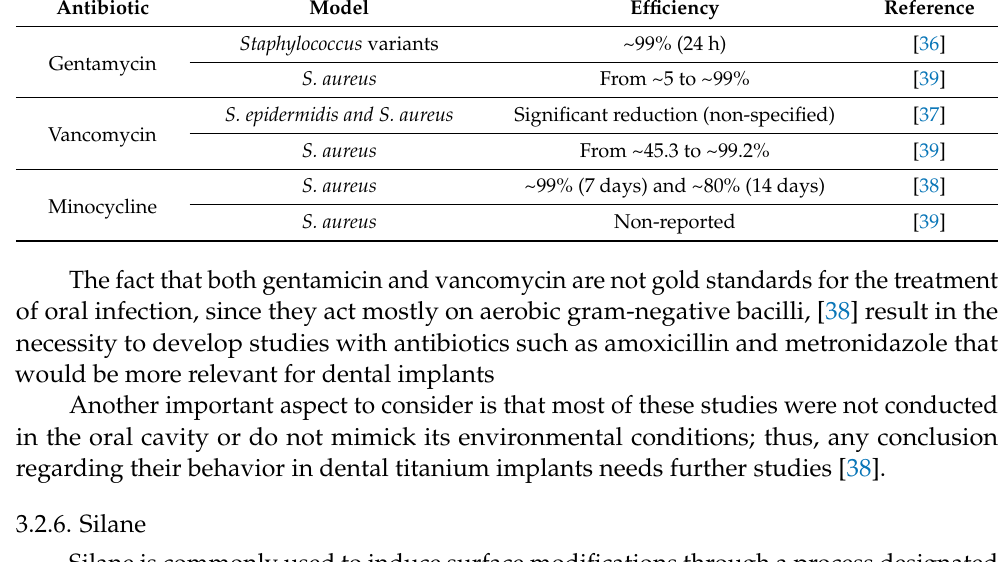
Table 1. Summary of results obtained with different antibiotics. Antibiotic Model Efficiency